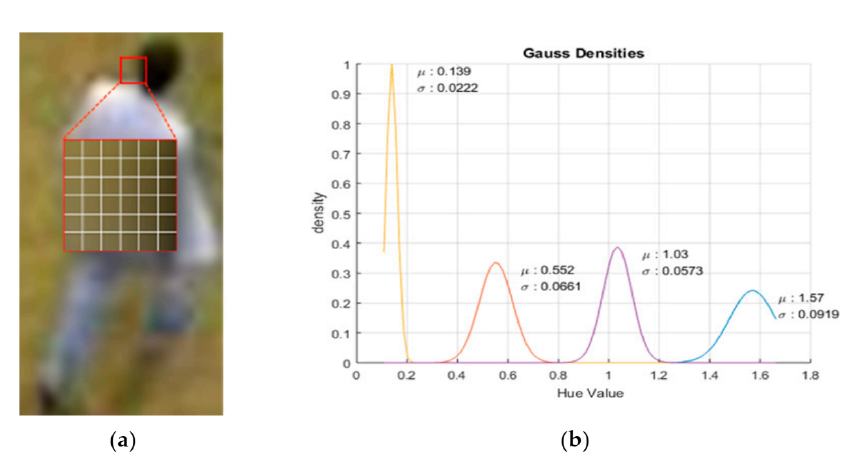
Figure 5. Patch characteristics. ( a ) Patch information; ( b ) GMM grouped color